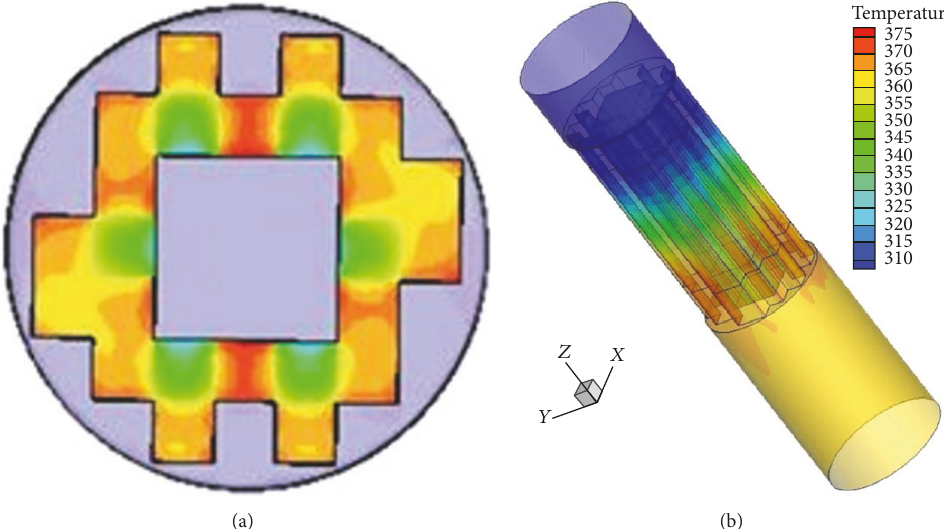
Figure 8: Temperature contours predicted by the thermal equilibrium model: (a) a section at the edge of the heat region and (b) the whole calculation region.